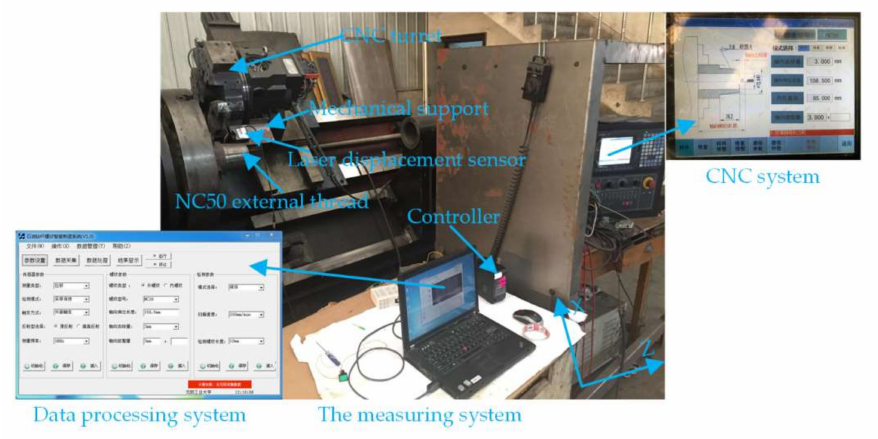
Figure 3. The on-machine measurement